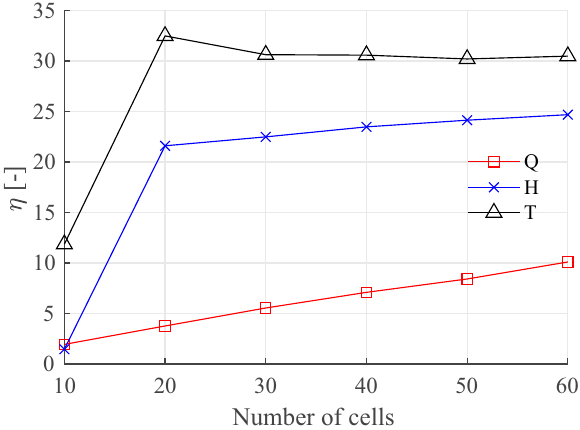
Figure 4: Structural eflciency η versus grid refinement for each grid pattern